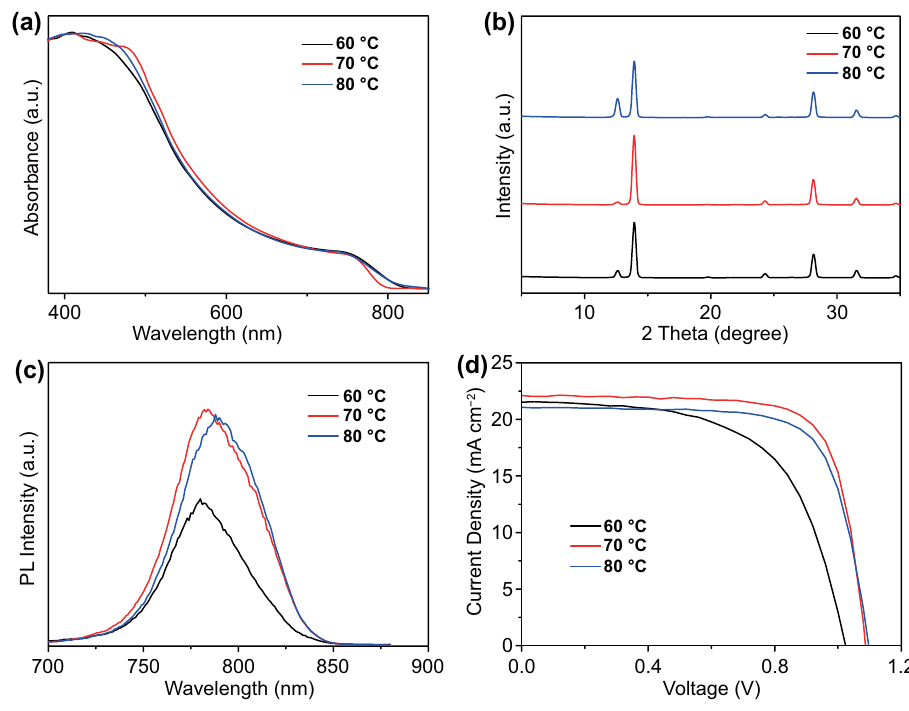
Fig. 4 a Absorbance spectra, b XRD patterns, c photoluminescence and d J–V curves of perovskite films prepared using the PbI 2 :CsI films fab- ricated on the different bed